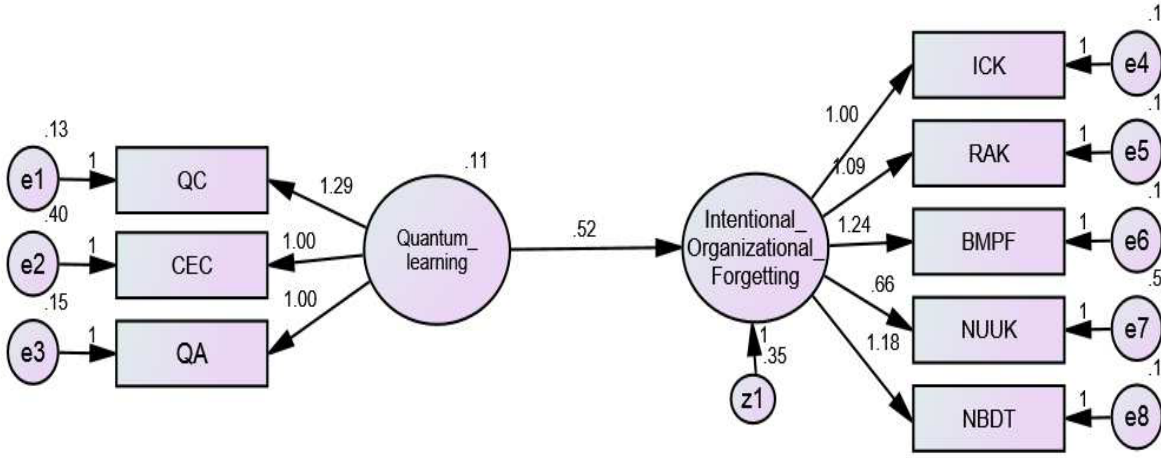
Fig. 5. Non-standard coefficients of the